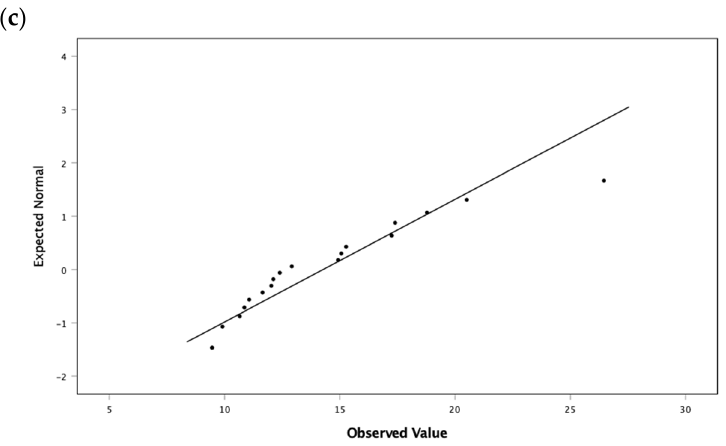
Figure 7. Normal Q–Q plot of ( a ) the total height of the measured data; ( b ) Petterson’s (1955) predicted value; e ( c ) Loetsch et al.’s (1973) predicted value.